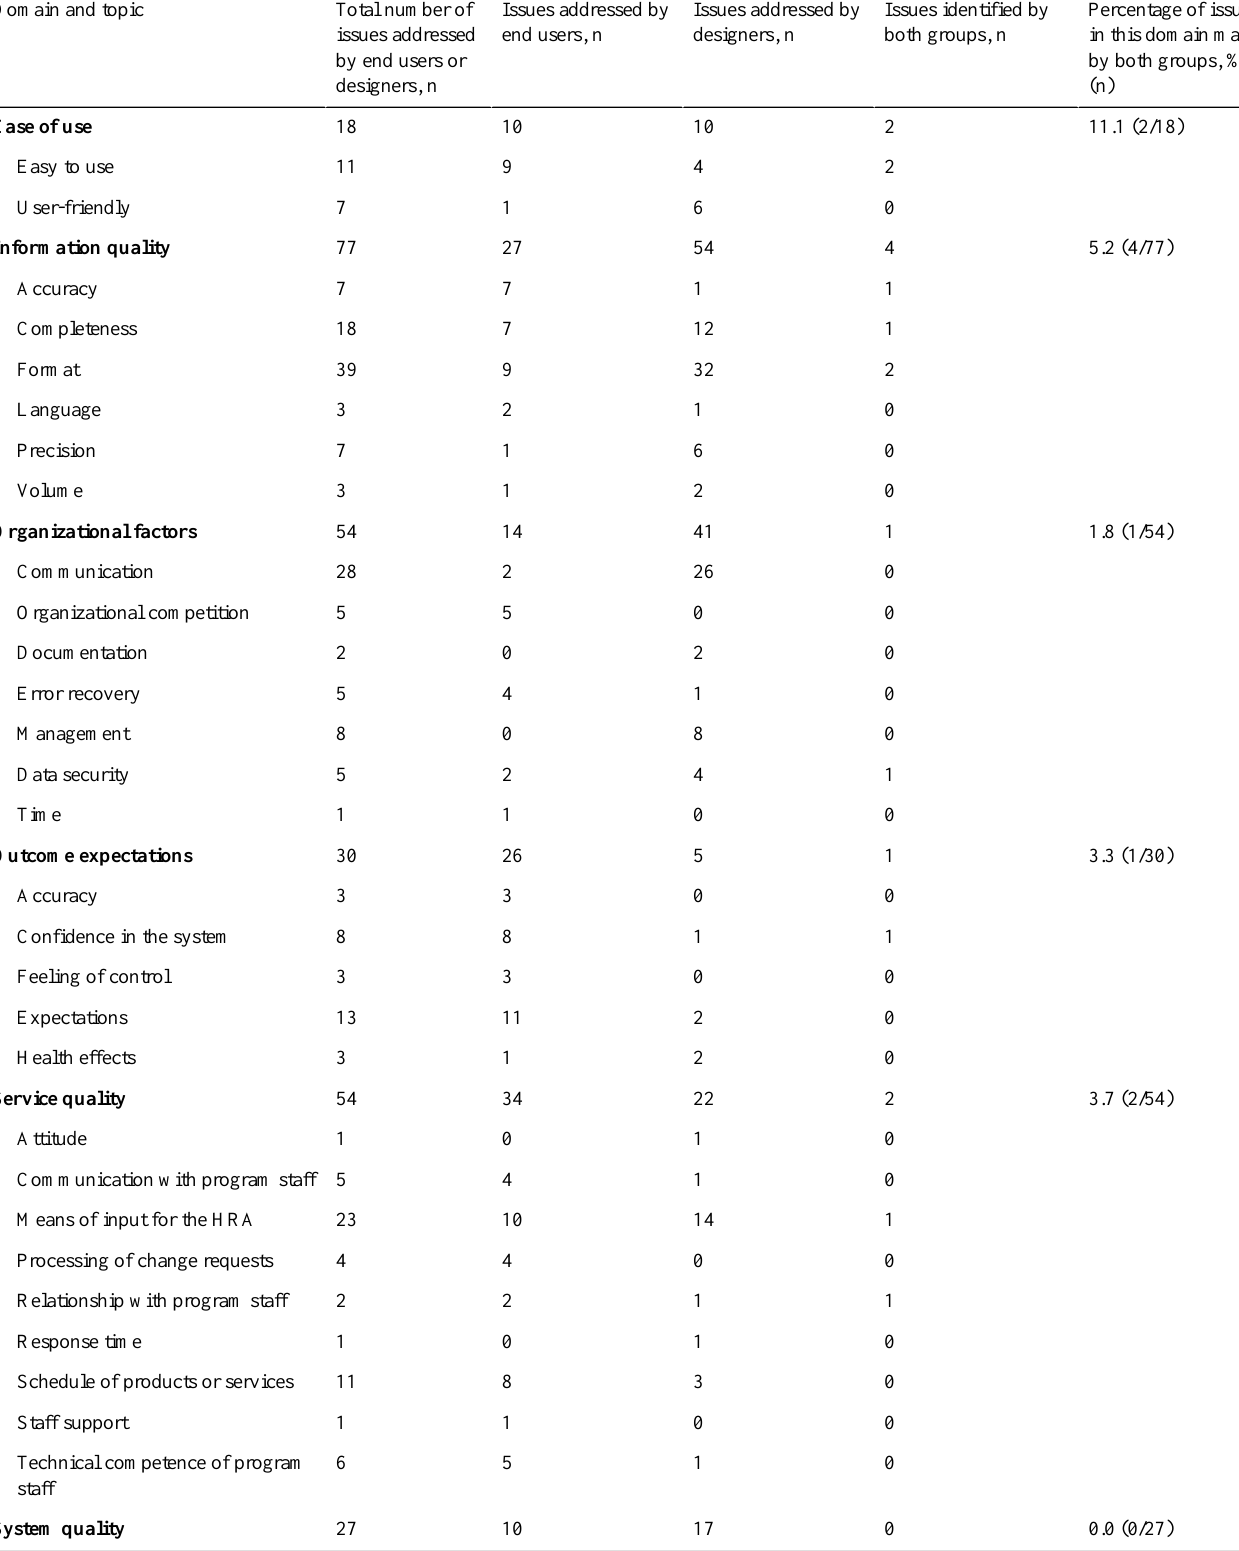
Table 1. Numbers of unique issues addressed in the end-user survey and in the designer focus group, categorized using constructs of user satisfaction and technology